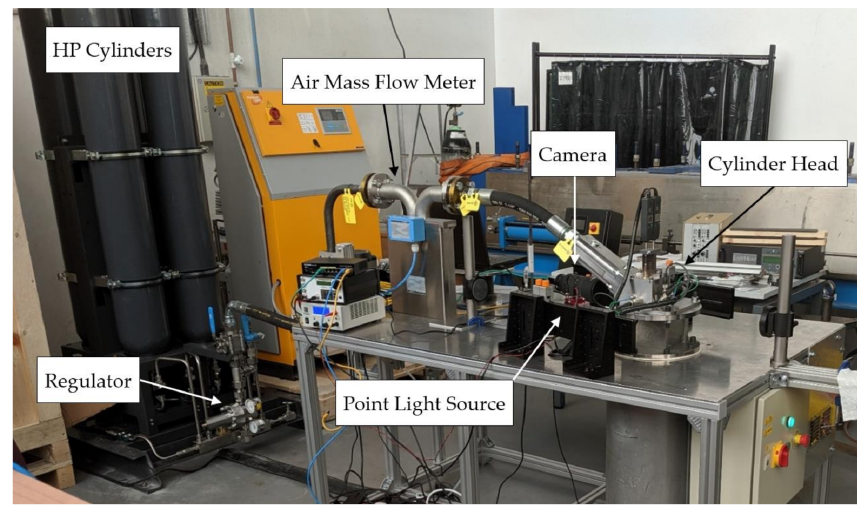
Figure 8. Overview of AMRC flow rig experiment setup.